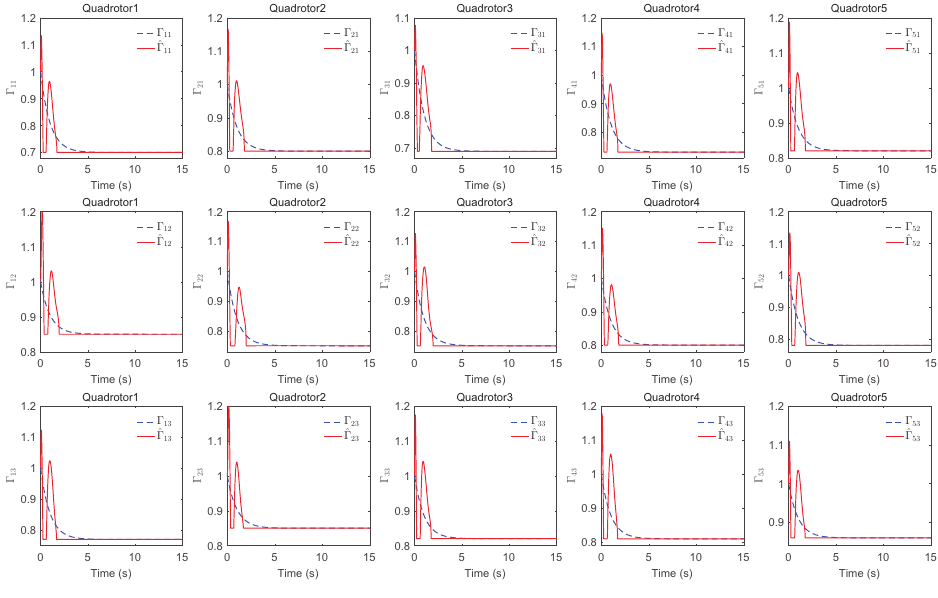
Figure 13. Estimation of multiplicative faults.